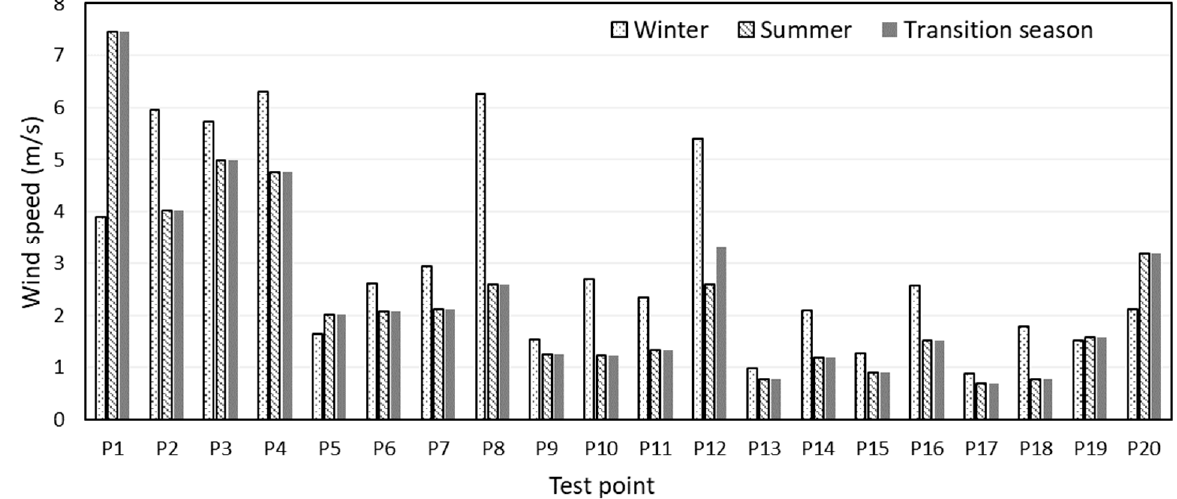
Figure 12. The wind speed of each test point in the different seasons.